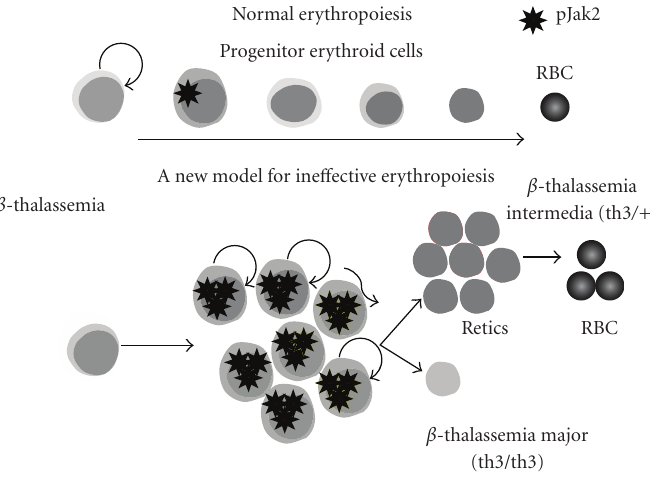
Figure 1: In normal erythropoiesis, physiological levels of EPO induce the phosphorylation of Jak2 in normal erythroid progenitors and sustain the di ff erentiation to mature RBC (top of the figure). In β -thalassemia, the high levels of EPO induce an uncontrolled proliferation of erythroid precursors, with a higher number of cells associated with the phosphorylated form of Jak2. In β -thalassemia intermedia, where a certain amount of β -globin is still synthesized, there is a high production of reticulocytes that eventually mature in RBC. In β -thalassemia major, where there is a complete lack of β -globin, the orythroid progenitors continue to proliferate and fail to mature into reticulocytes and RBC or undergo apoptosis.